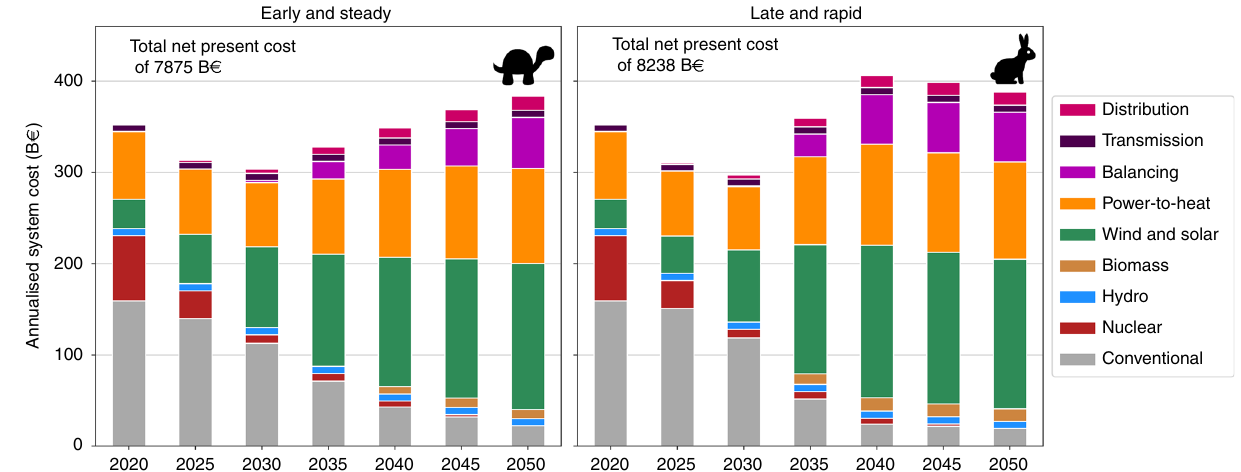
Fig. 2 Annualised system cost for the European electricity and heating system throughout transition paths Early and Steady and Late and Rapid shown in Fig. 1. Conventional includes costs associated with coal, lignite and gas power plants producing electricity as well as costs for fossil-fuelled boilers and CHP units. Power-to-heat includes costs associated with heat pumps and heat resistors. Balancing includes costs of electric batteries, H 2 storage and